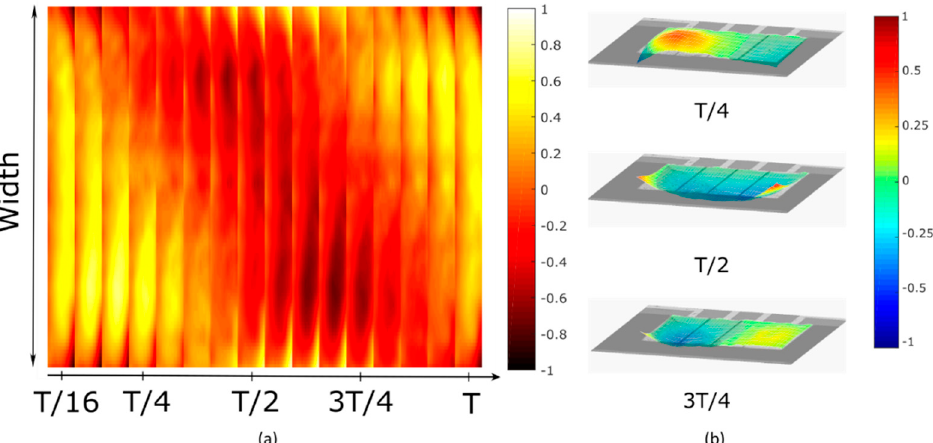
Figure 4. Time frame of the measured traveling wave (TW) by combining Modes (11) and (12): ( a ) 2D representation and ( b ) 3D representation (a video clip is available (Video S1)). The color scale represents the normalized displacement of the cantilever. T corresponds to the period of the TW. TWs may be generated by combining different couples of modes on the same device. Figure 5a shows the frequency response of the cantilever in a different range between 700 kHz and 1.1 MHz.